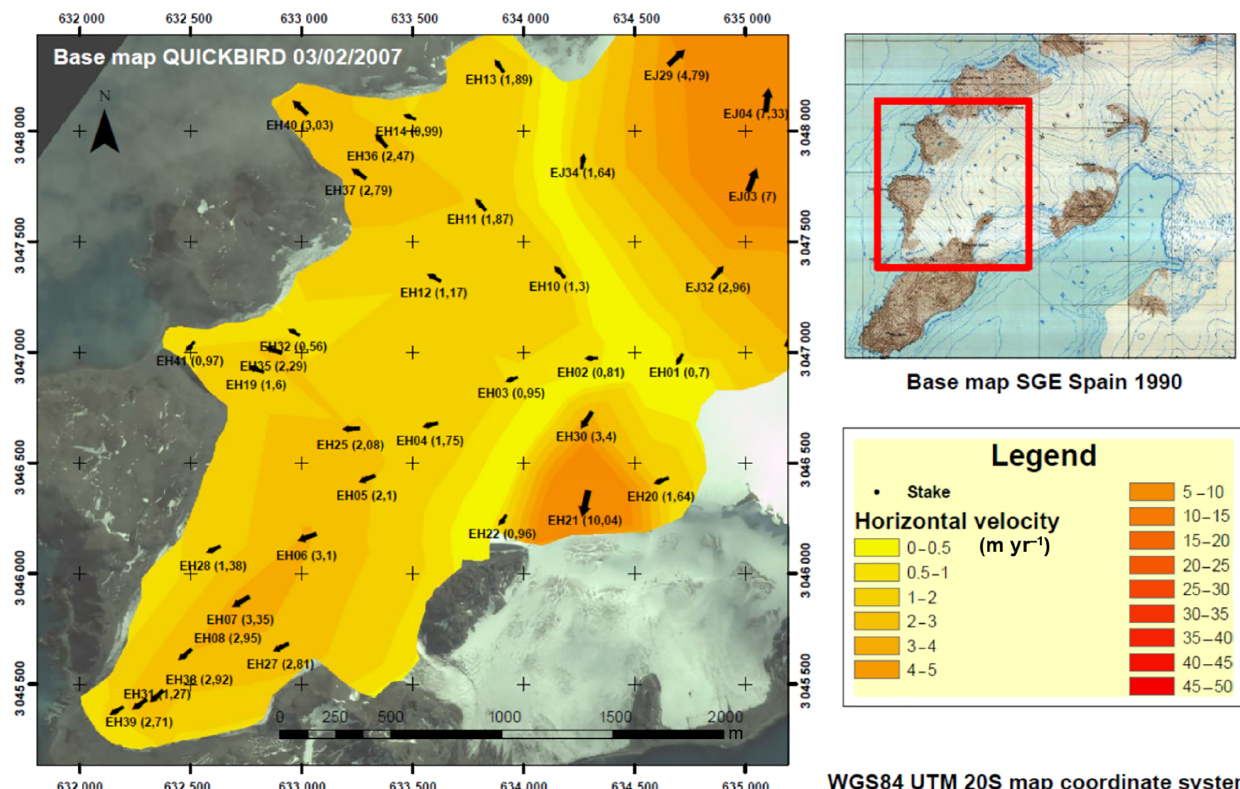
Figure 4. Map of contour lines of the absolute values of the horizontal velocity for Hurd Glacier, obtained from the spatial interpolation of the corresponding vector velocity field, calculated for 13 February 2013. The magnitude of velocity is denoted in brackets, arrows indicate direction. The yellow near-zero velocity band indicates the approximate location of the ice